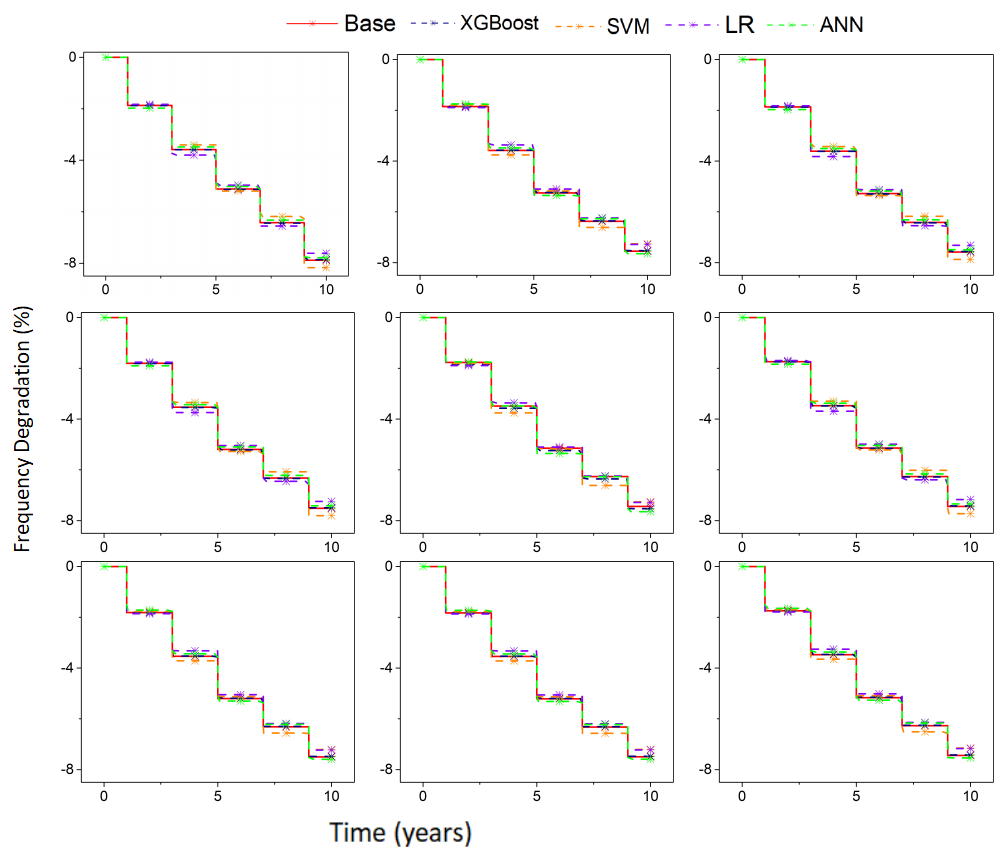
Figure 9. Aging prediction results of the different ML models under different stress signals and LUT